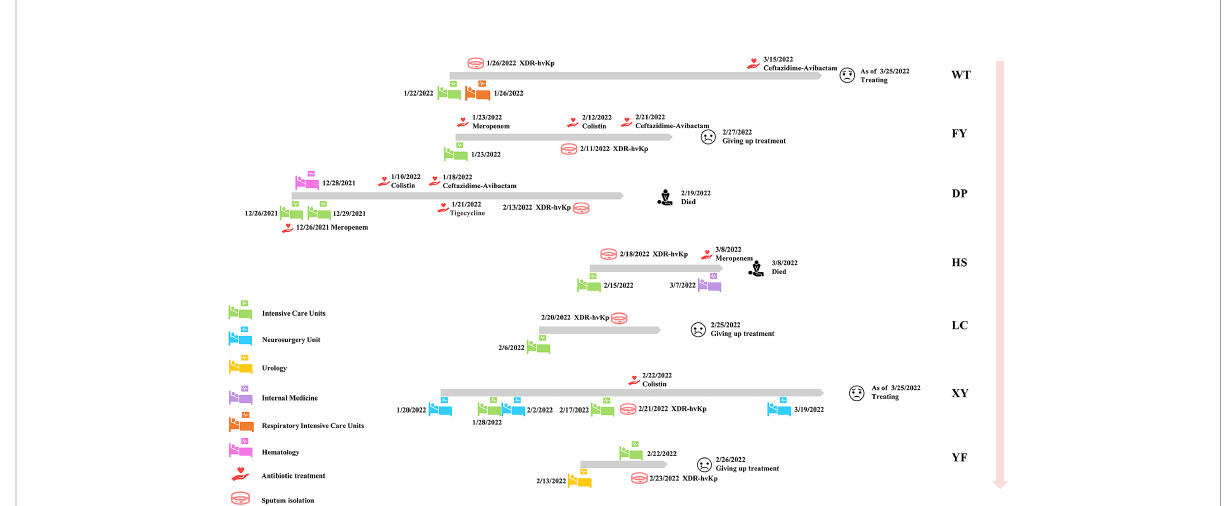
FIGURE 1 Epidemiology of seven patients in this study. Each grey broadband represents the timeline of one patient, the fi gure indicates the date of transfer of the patient to the new ward and the date of isolation of the strain as well as the date of the patient ’ s fi rst use of this type of antibiotic in this investigation. The outcome of each patient is represented at the end of each grey broadband. The names of patients/strains are next to the pink